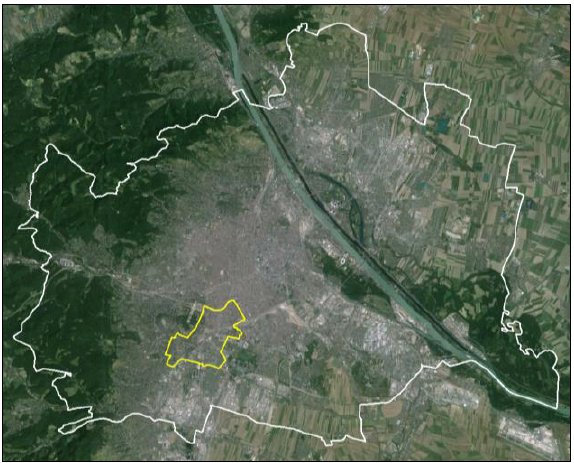
Figure 1. Boundaries of Vienna (in white) and extents of the district of Meidling (in yellow). Image source: Google